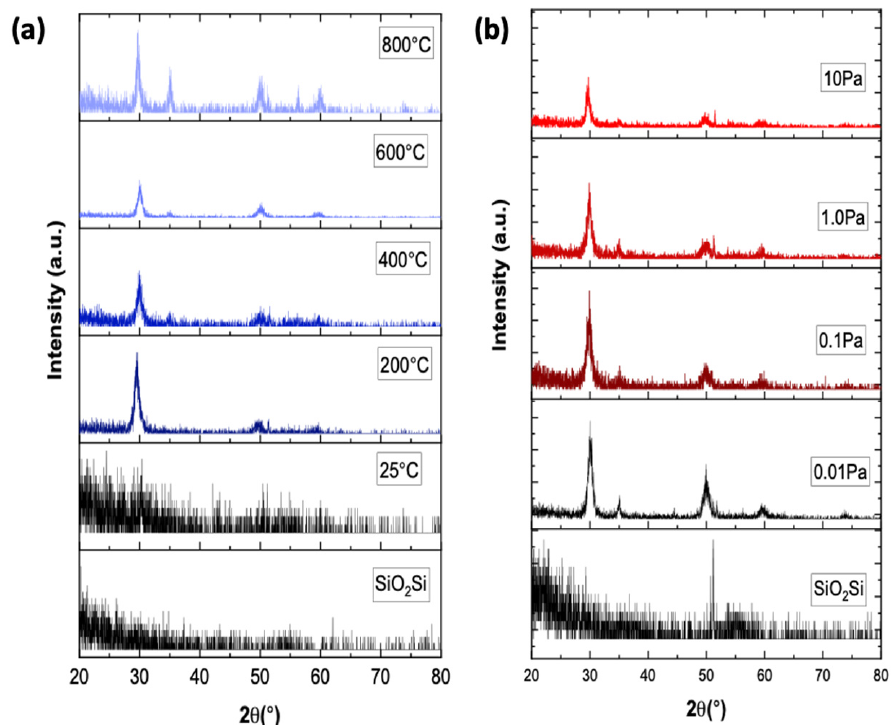
Figure 1. XRD stacked pattern. ( a ) Diffraction peaks of ScYSZ thin film on SiO 2 -Si prepared with various substrate temperatures ( T s = 25 ◦ C, 200 ◦ C, 400 ◦ C, 600 ◦ C, and 800 ◦ C) at P O ( b ) XRD of ScYSZ thin film on SiO 2 -Si prepared at T s = 600 ◦ C, with various oxygen partial pressures, P O = 0.01 Pa, 0.1 Pa, 1.0 Pa and 10 Pa.